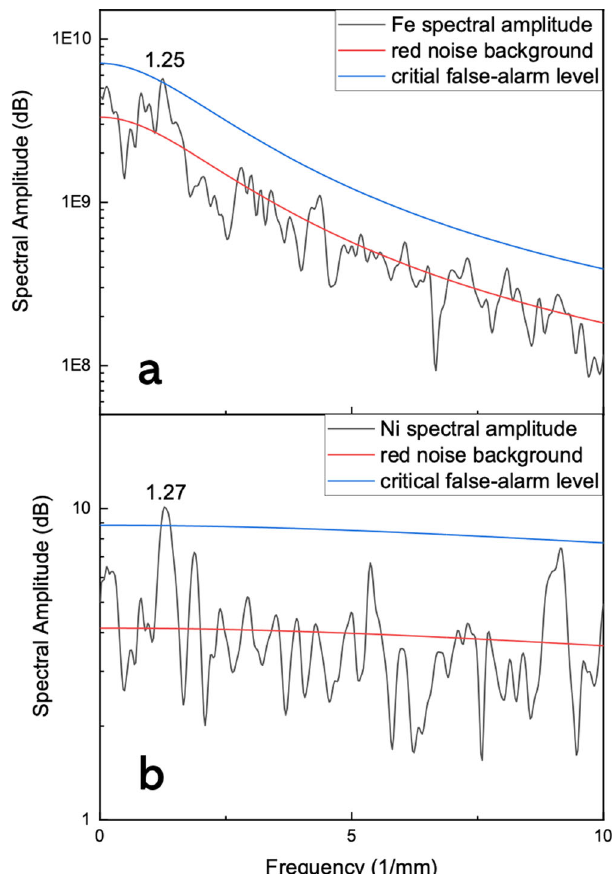
Fig. 2 Spectral patterns of Fe and Ni for the Kuruman BIF section. a , b The spectral patterns of Fe and Ni are shown in black lines, largely consistent with their red-noise background (red lines). Peaks above the critical false- alarm level (99.77%, blue lines) are labeled. Analyses were carried out with an oversampling factor of 4, 10 WOSA segments, and the Blackman – Harris data